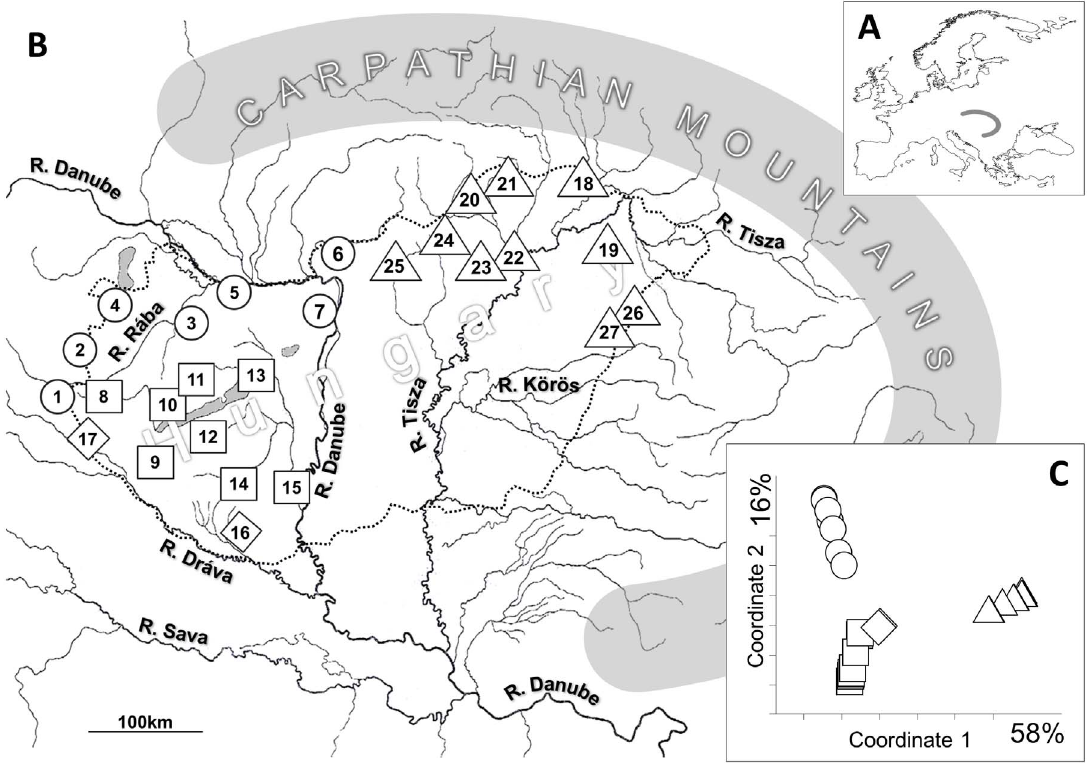
Figure 1. Location of the Carpathian Basin in Europe (A), location of the sampling sites (1–27) in the Carpathian Basin (B) and PCoA representation of hydrologic distances between the sampling sites (C). Hungarian country border is marked with the dotted line. Different symbols refer to sites belonging to different catchment areas: # - North Danubian; % - Middle Danubian; e - South Danubian and n - the Tisza River catchment. For detailed information see Table 1.